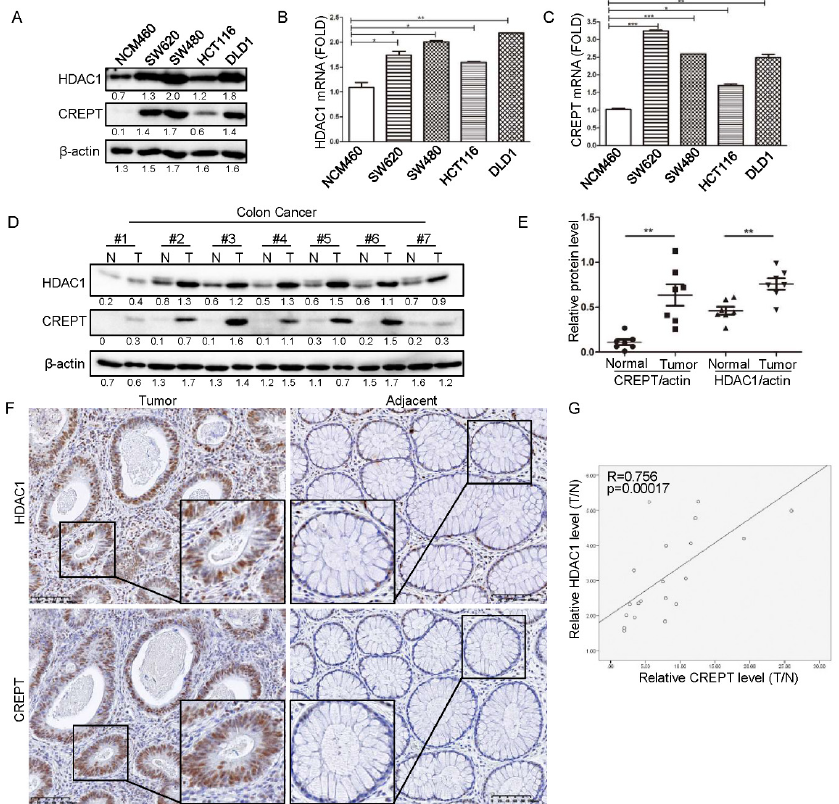
Figure 1. The correlation of HDAC1 and CREPT in human tumors. ( A ). CREPT expression is positively correlated to HDAC1 at the protein level in colon cancer cells. The endogenous protein levels of HDAC1 and CREPT in colon cancer cell lines (SW620, SW480, HCT116, DLD1) and epithelial cells (NCM460) are shown. β -actin was used as a loading control. ( B , C ). Both HDAC1 ( B ) and CREPT ( C ) are highly expressed in colon cancer cells when compared with the normal cells at the mRNA level. The mRNA levels were normalized to the fold change relative to β -actin. ( D ). Both HDAC1 and CREPT are elevated in the tumor tissues compared with the adjacent normal tissues from human colon cancers. Western blot analyses were based on β -actin as a loading control. N represents paired adjacent normal tissue and T represents tumor tissue from the same patient. The bands were quantified using ImageJ and presented as a value normalized according to the moderate level of a band in each blot. ( E ). The relative level of CREPT and HDAC1 in adjacent normal and tumor tissues are shown. The ratio of CREPT or HDAC1 vs actin was calculated by quantifying the bands from the Western blot in ( D ). The closed circle represents normal tissue for CREPT/actin, the square represents tumor tissue for CREPT/actin, the triangle represents normal tissue for HDAC1/actin and the inverted triangle represents tumor tissue for HDAC1/actin. ( F ). HDAC1 and CREPT were co-stained in human colon tumor tissue. Immunohistochemical staining was performed with an antibody against CREPT or HDAC1. ( G ). A graphical presentation of correlation of CREPT and HDAC1 in colon cancer. The levels of CREPT and HDAC1 in tumor tissue and the adjacent normal tissue were quantified using Image J. The ratio of CREPT ( X -axis) or HDAC1 ( Y -axis) level in tumor tissue to the adjacent normal tissue was calculated. SPSS was employed to figure out the correlation coefficient between the two proteins. (* p < 0.05, ** p < 0.01, *** p <